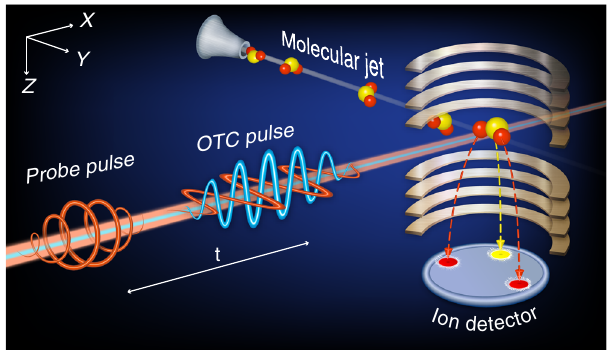
Fig. 1 Layout of the experiment. A supersonic gas jet of SO 2 molecules subject to a pair of synchronized two-color laser pulses with orthogonal polarizations in an ultrahigh vacuum chamber of COLTRIMS (COLd Target Recoil Ion Momentum